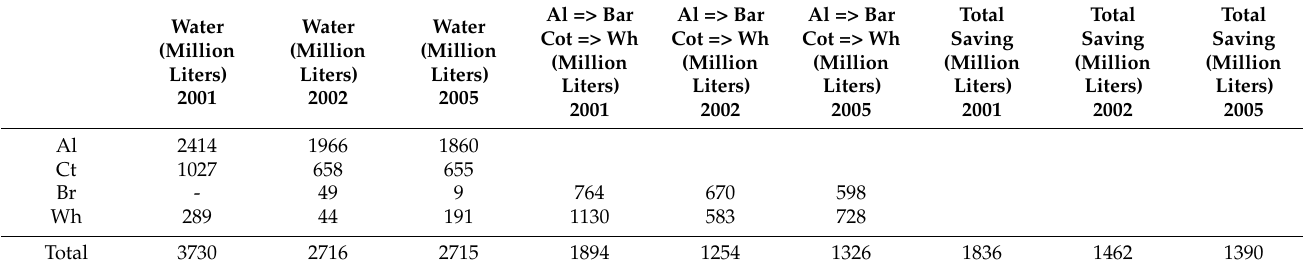
Table 10. Example of water savings by switching crops (Al = Alfalfa; Ct = Cotton; Br = Barley; Wh = Wheat).